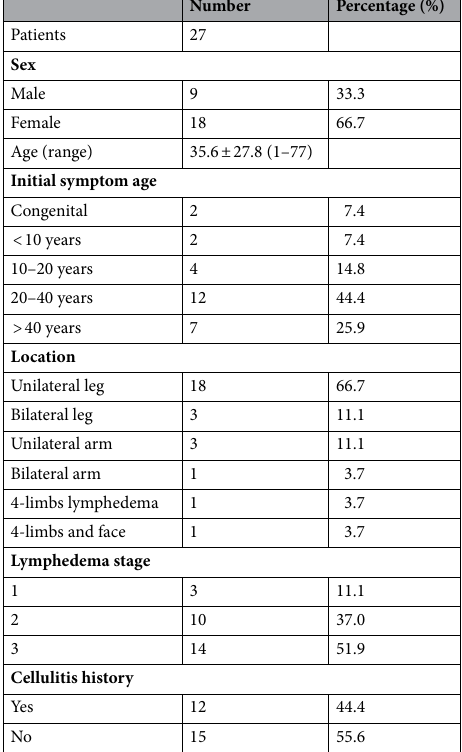
Table 1. Patient demographics and phenotypic classifications.